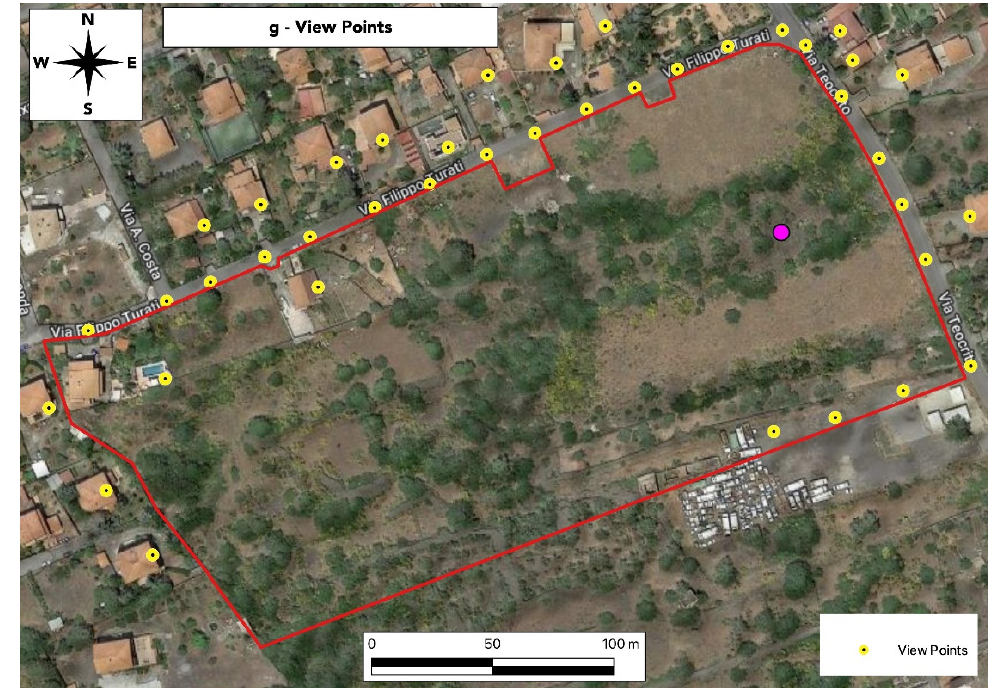
Figure 18. Localization of the viewpoints used for the view shed analysis.